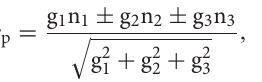
to 0.05 to simulate cartilage-to-cartilage contact (McCann et